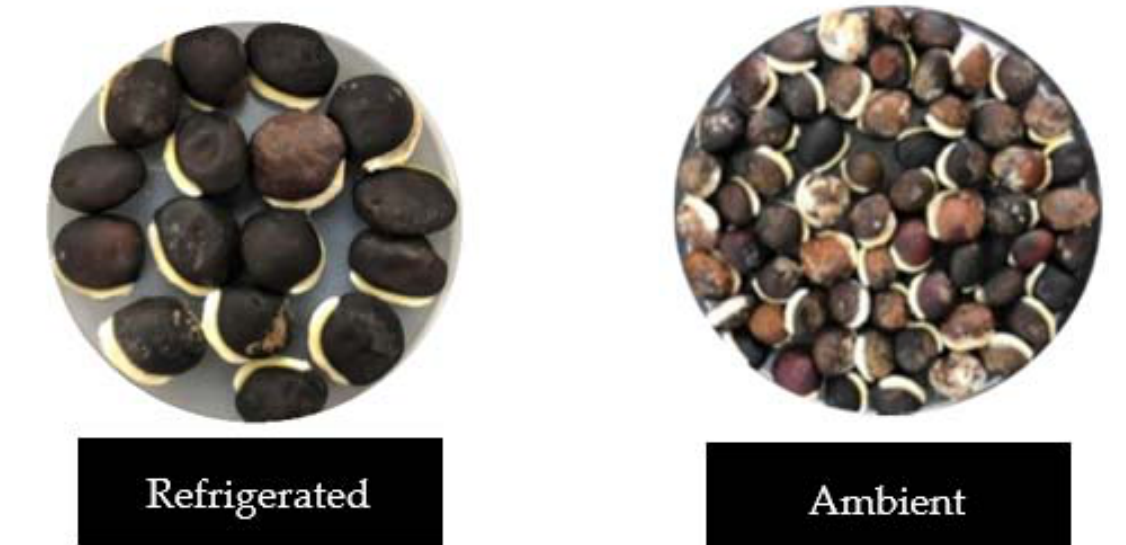
Figure 4. Effects of different storage temperatures and seed moisture content on seed physical conditions of lablab bean seeds.